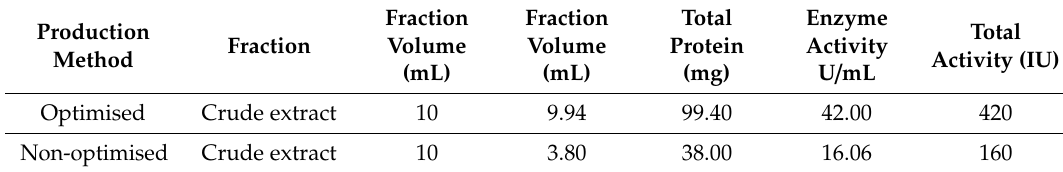
Table 9. Comparison of S. griseus recombinant β -glucosidase production under optimised and pre-optimised conditions. The non-optimised expression was carried out using basal medium (LB broth) overnight at 37 ◦ C, 220 rpm and cells were induced with 1 mM IPTG when OD 600 nm reached 0.6.